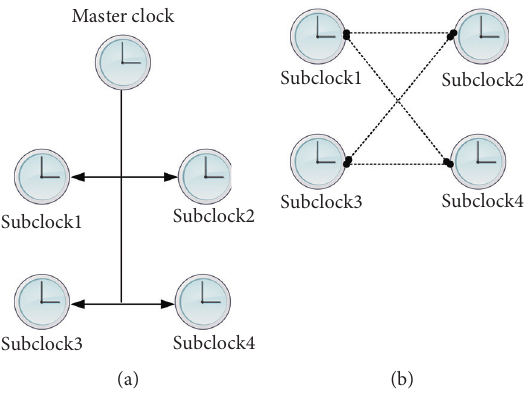
Figure 4: (a) Monoclock system and (b) multiclock